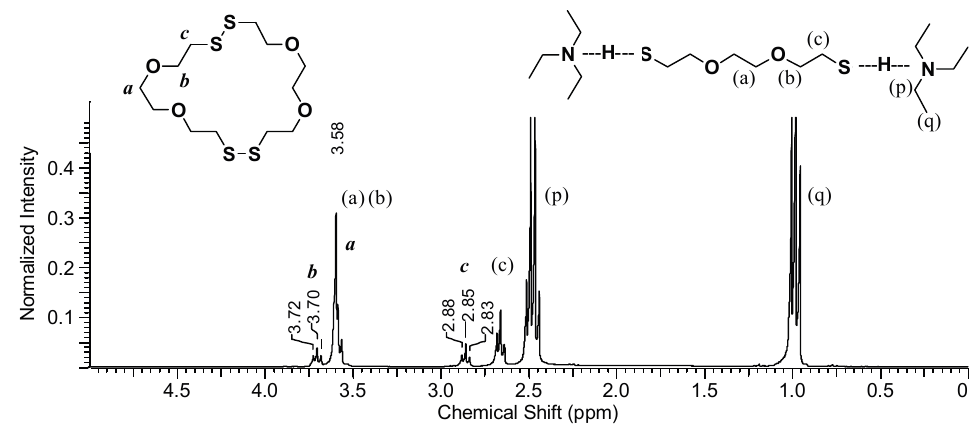
Figure 6. 1 H-NMR spectrum of the organic phase after H 2 O 2 addition shows a mixture of DODT species and TEA (3 s relax; 64 scans; 300 MHz; CDCl 3 ).